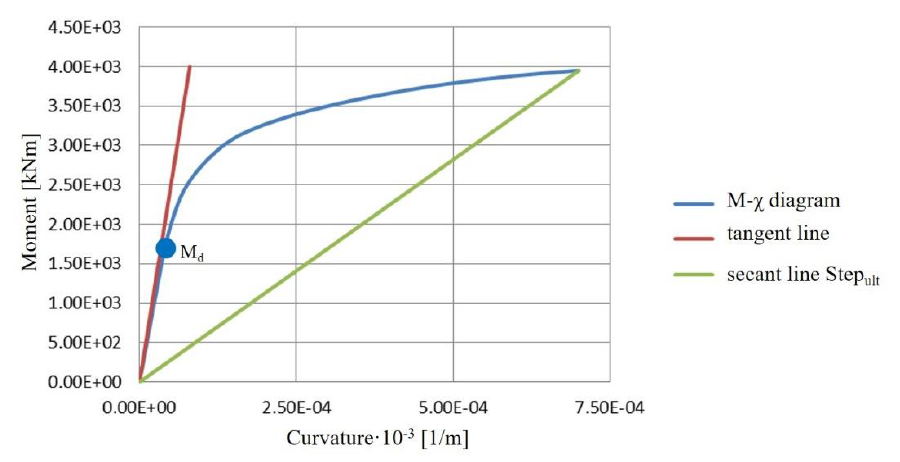
Figure 19. M- χ diagram of the base cross-section. Figure 19. M-χ diagram of the base cross-section. Table 5. The ratio between the calculated stiffness obtained in correspondence to the Step fun and the elastic stiffness (Step el,lim ).